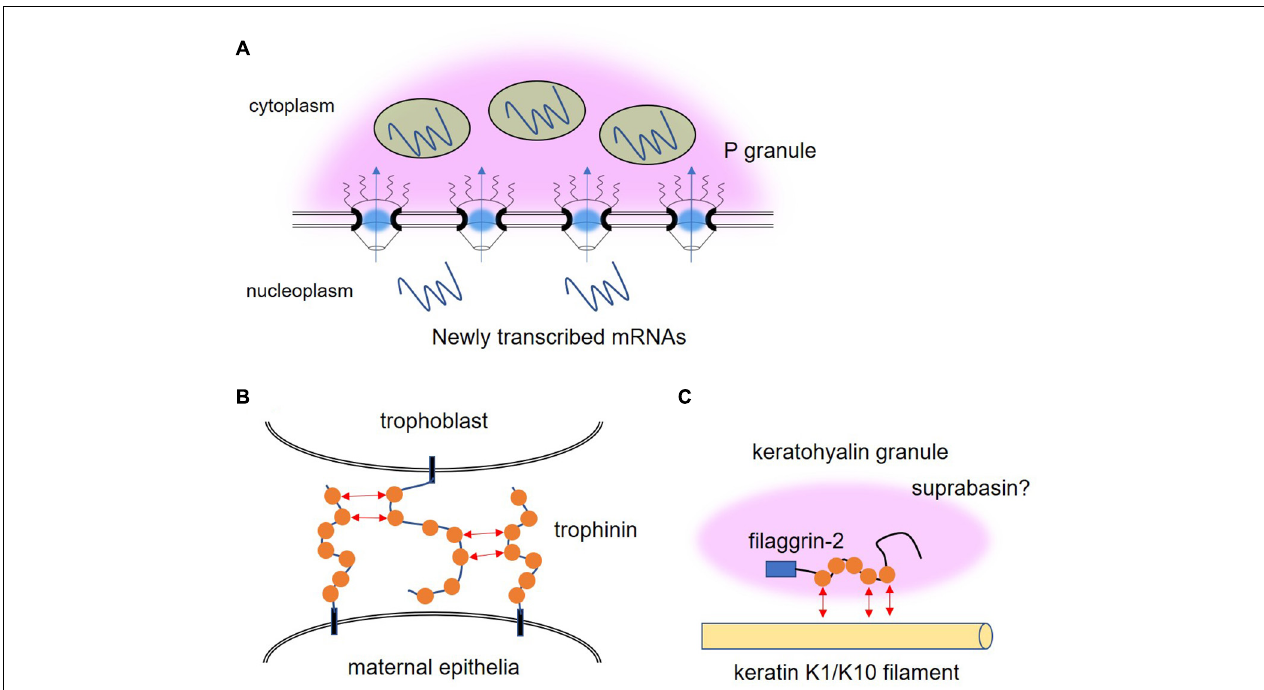
FIGURE 2 | Illustration of the possible roles of phenylalanine-glycine (FG) repeat proteins other than in the nuclear pore. (A) P granule (pink cloud) is attached to the nuclear pores in the adult germline of C. elegans by the interaction between FG repeats in GLH proteins, the main constitutive components of P granules, and the meshwork structure formed by nucleoporins containing FG repeat domains. Newly transcribed mRNAs traverse P granule and the small RNA machinery (green circles) that resides in P granules might prevent excessive flux of RNA to the cytoplasm. (B) The FG motifs (orange circle) of trophinin mediate homophilic adhesion between trophoblast and maternal epithelia during embryonic implantation. (C) FG repeat-containing proteins, filaggrin-2, keratin K1, keratin K10, and suprabasin, are expressed in the same epidermal keratinocytes and contribute to the formation of keratohyalin granules, which drive skin barrier